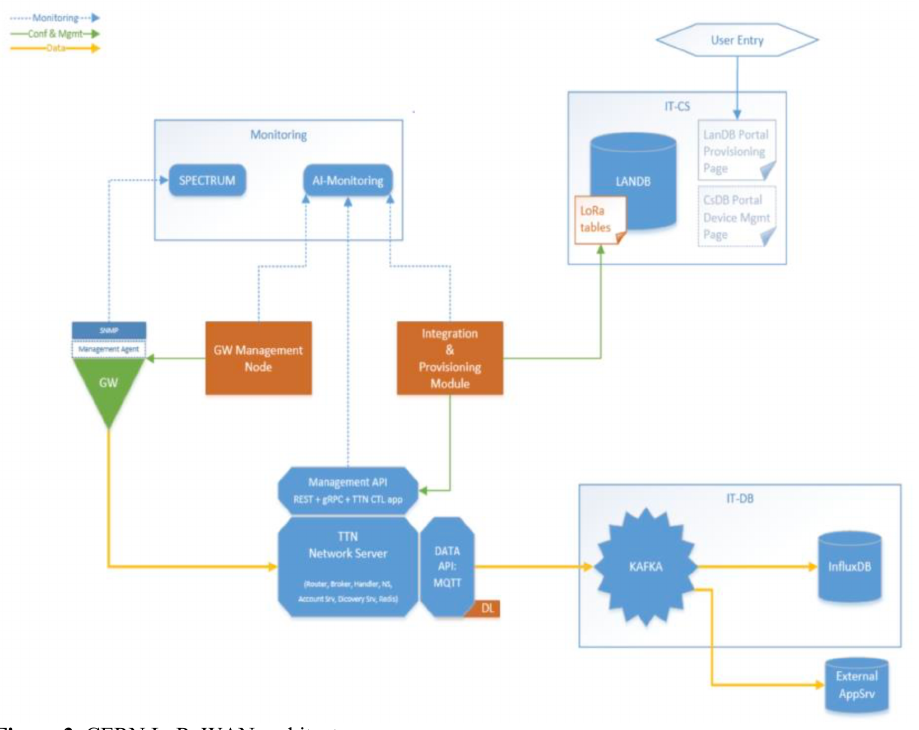
Figure 3. CERN LoRaWAN